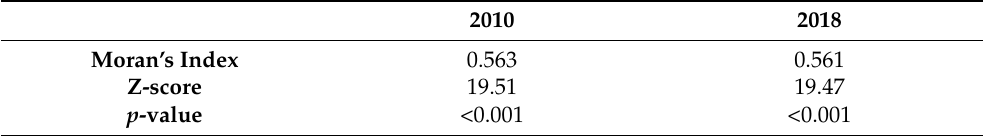
Table 3. Spatial autocorrelation statistics results for the carbon storage in each of the two time periods.